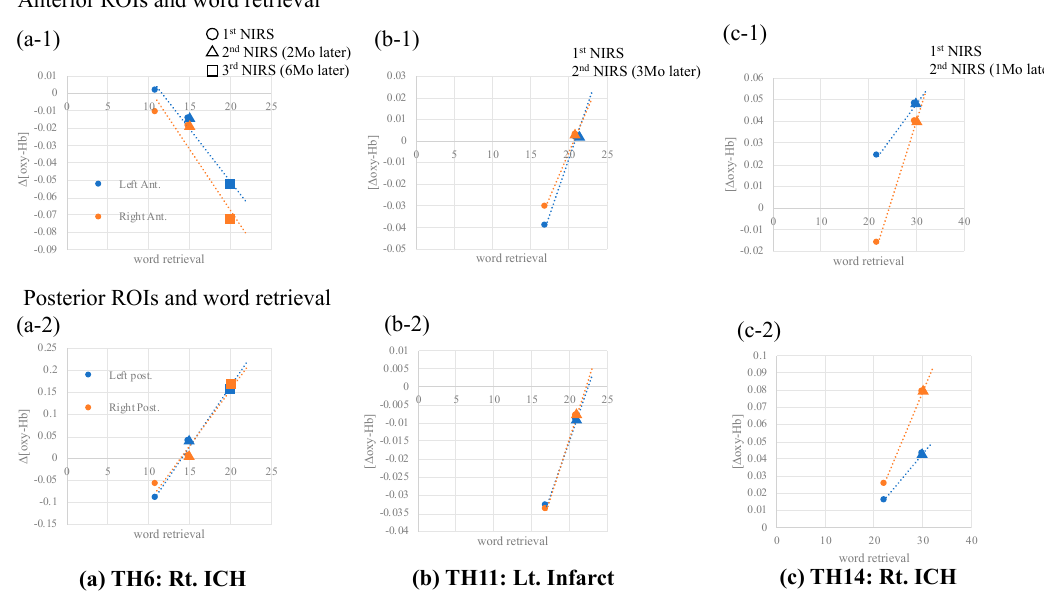
Figure 5. Follow-up NIRS. NIRS data were obtained from three patients (( a ) TH6, ( b )TH11, ( c ) TH14). All patients had improved word retrieval ability and [oxy-Hb] at almost all ROIs, together with increased VFT performance improvement. Ant.: anterior ROI; Post.:posterior ROI; Mo: month.